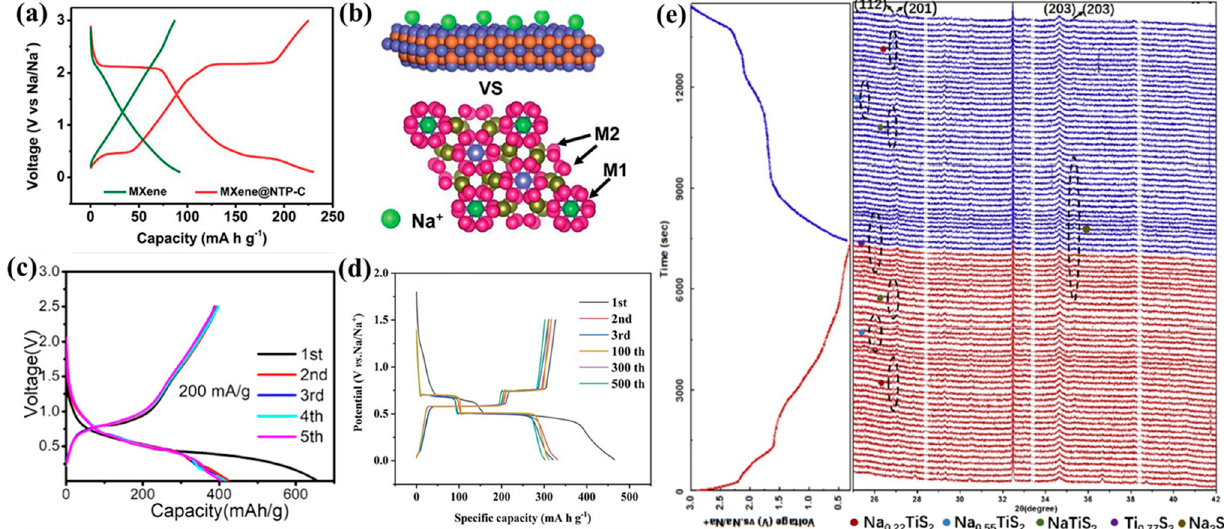
Figure 8. ( a ) The discharge–charge profiles of pure MXene and MXene@NTP-C. ( b ) Schematic com-